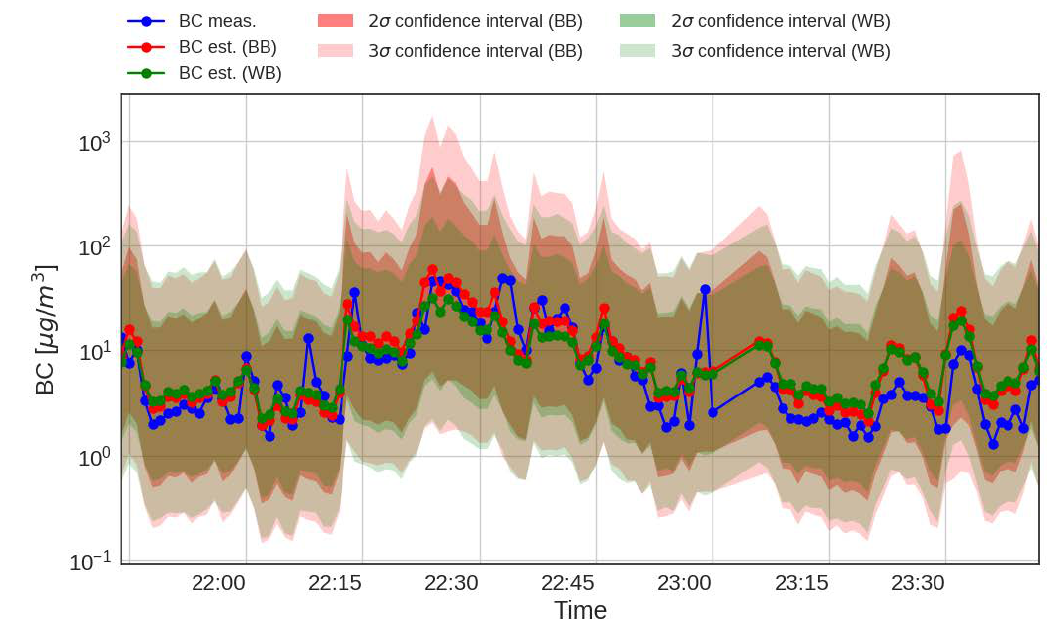
Figure 4. Time-series data of BC mass concentrations in the Amman city center. The blue dot is the measured BC, whereas the red dashed line and the light green region are the measured BC and its 2 σ uncertainty.